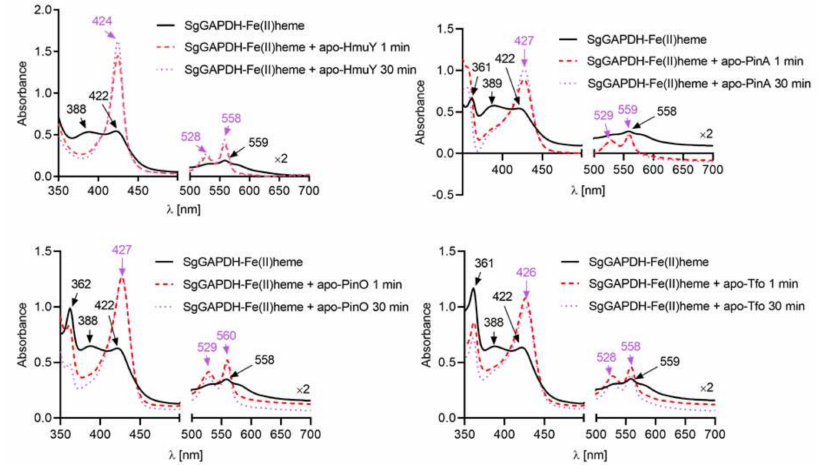
Figure 6. Heme sequestration by HmuY and its homologs from SgGAPDH-heme complex under reducing conditions. SgGAPDH-heme complex (10 µ M) was incubated under reducing conditions with an equimolar concentration of HmuY, PinO, PinA, or Tfo apo-proteins. Changes in absorption spectra analyzed by UV-visible spectroscopy are shown at indicated time